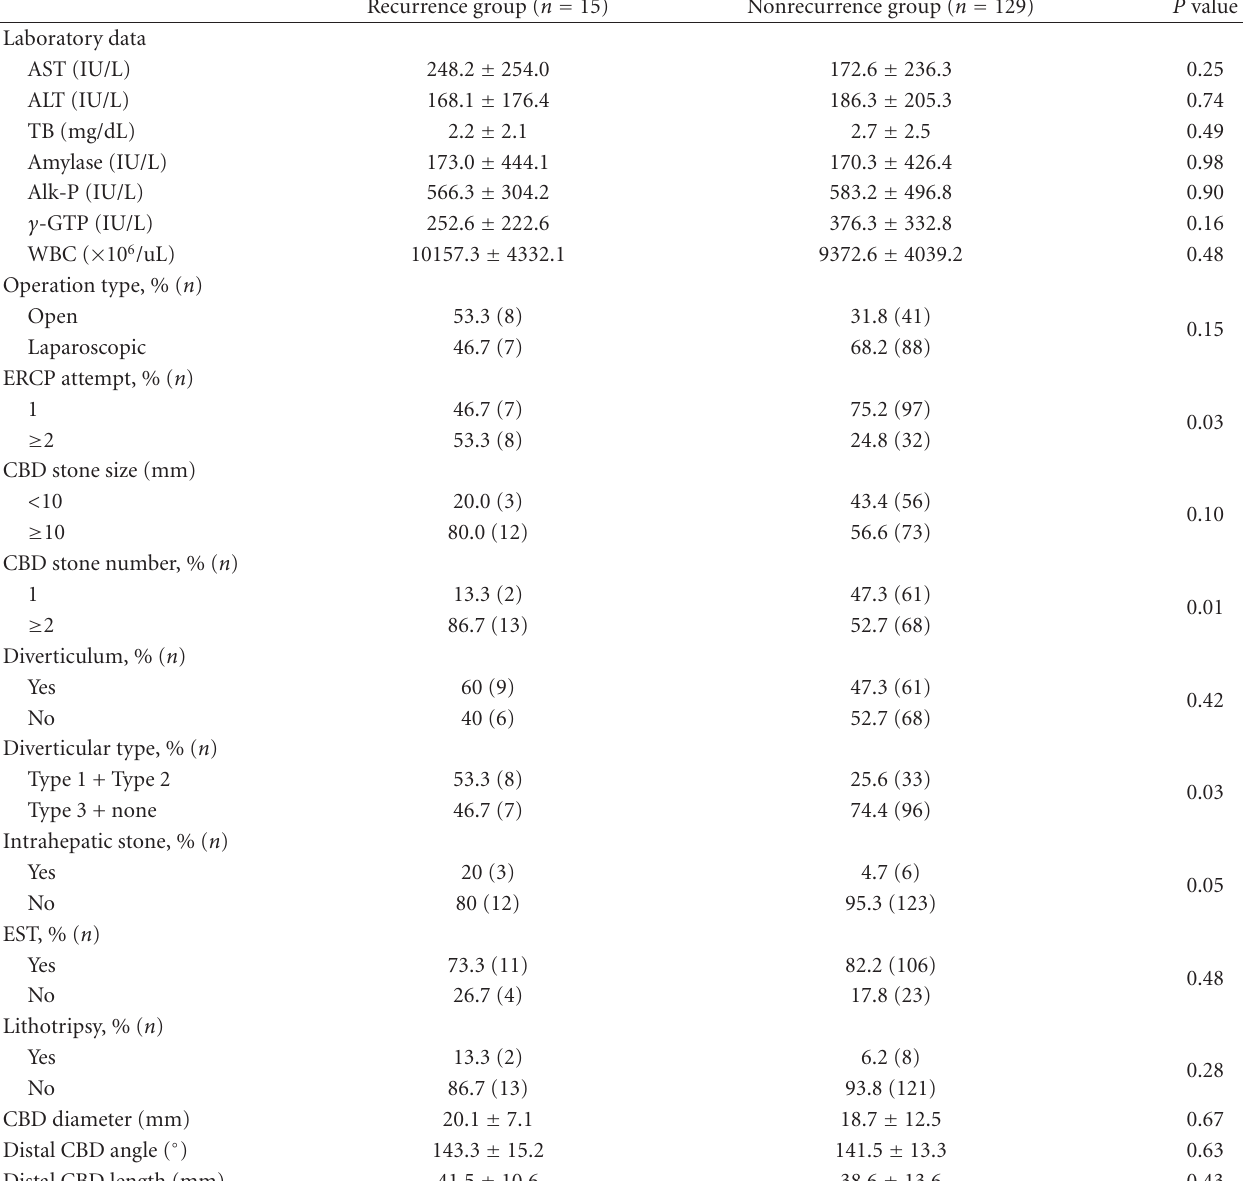
Table 2: Univariate analysis of the risk factors for recurrence of symptomatic CBD